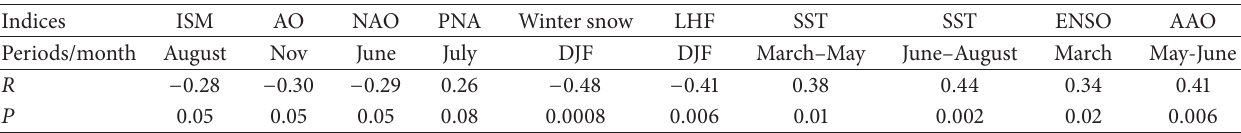
Table 1: The correlation coefficients and corresponding significant level between regional summer extreme precipitation index (95% percentile) and the initial impact factors selected in the present study.